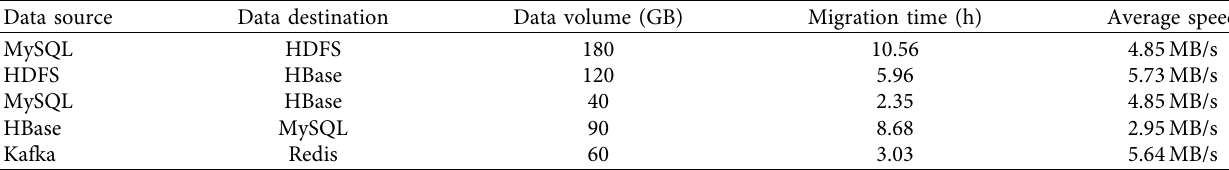
Table 1: Data migration function effect